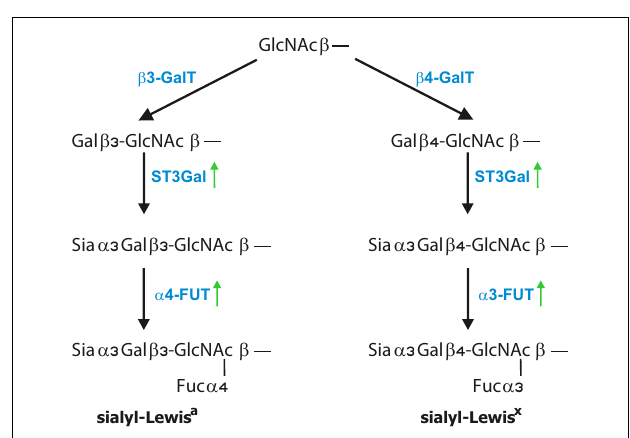
FIGURE 2 | Formation of Lewis antigens .Terminal GlcNAc residues, particularly on core 2 structures, are further extended by addition of β 1,4 galactose, for Lewis x epitope, and β 1,3 galactose, for Lewis a epitope.This is further followed by the addition of α 2,3-linked sialic acid to Gal by ST3Gal enzymes and finalized by the addition of α 1,3-linked fucose for sLe x and α 1,4-linked fucose for the sLe a antigen. FUT3 finalized the synthesis of Lea antigen, while FUT6 and FUT7 were shown to finalize Le x